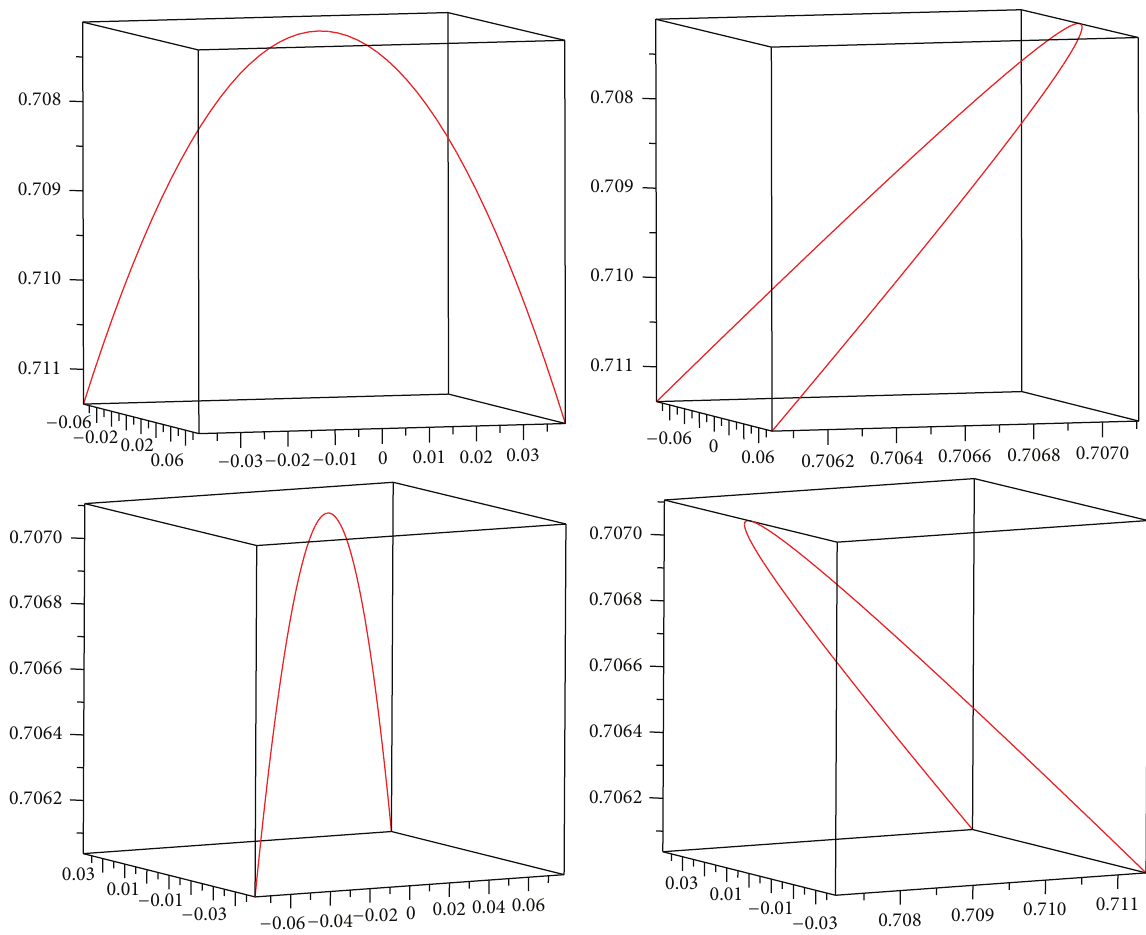
Figure 1: The projected image of Mannheim curve 𝛼 in S 3 1